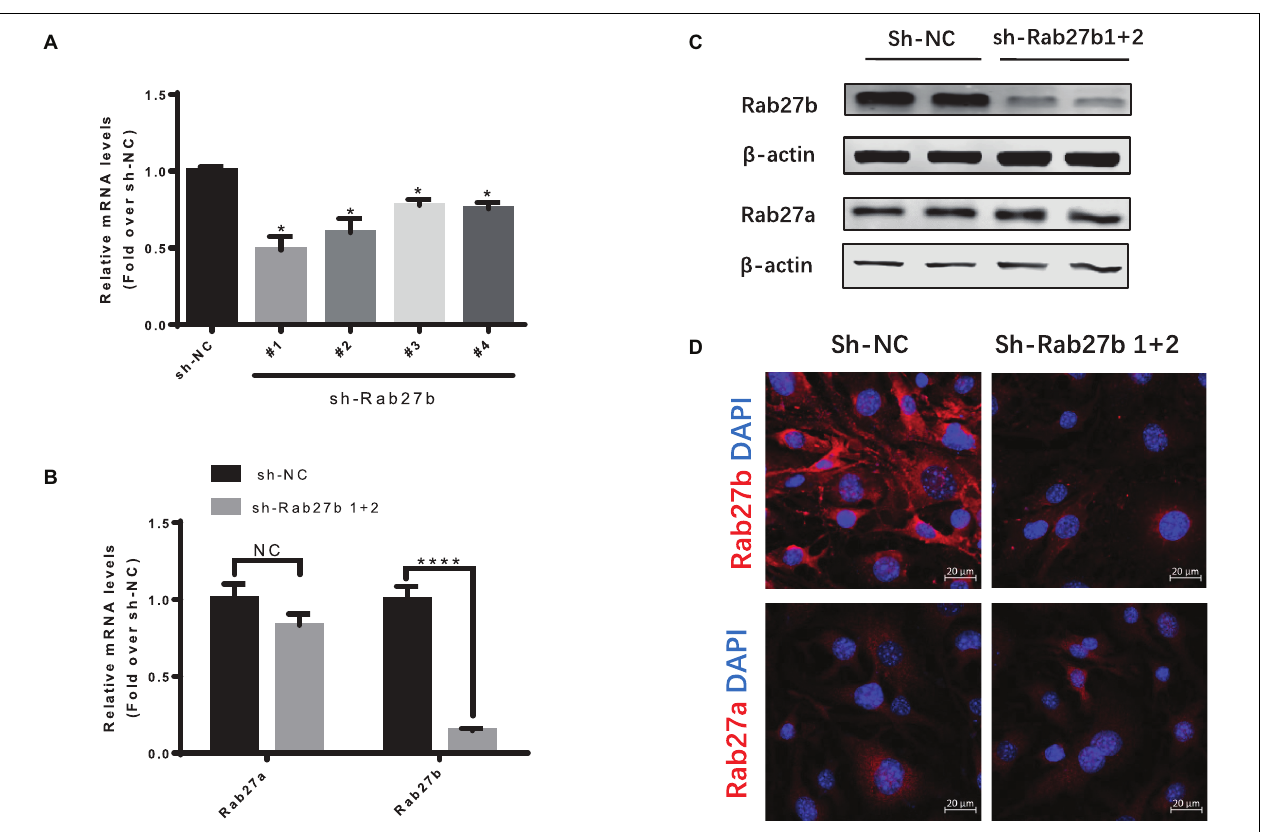
FIGURE 2 | Knockdown of Rab27b in C-MSCs via lentiviral shRNAs vector transduction. (A) qRT-PCR analysis of Rab27b in C-MSCs cells infected with lentiviral vectors encoding shRNA targeting Rab27b mRNA (sh-Rab27b-1, sh-Rab27b-2, sh-Rab27b-3 and sh-Rab27b-4) or negative control (sh-NC). β -Actin was used as endogenous control. Results are shown as mean ± SD (* p < 0.05 vs. sh-NC, n = 3). (B) qRT-PCR analysis of Rab27a and Rab27b in C-MSCs infected with sh-Rab27b1 + 2 (lentiviral vectors encoding sh-Rab27b1 and lentiviral vectors encoding sh-Rab27b2) or negative control (sh-NC). GAPDH was used as endogenous control. Results are shown as mean ± SD (**** p < 0.0001 vs. sh-NC, n = 3). (C) Western blotting of Rab27b and Rab27a protein using β -actin as a loading control. (D) Immunofluorescent staining of Rab27b and Rab27a (red) in C-MSC sh − NC and C-MSC sh − Rab27b1 + 2 ; cell nuclei were counterstained with DAPI (blue) (scale bar = 20 µ